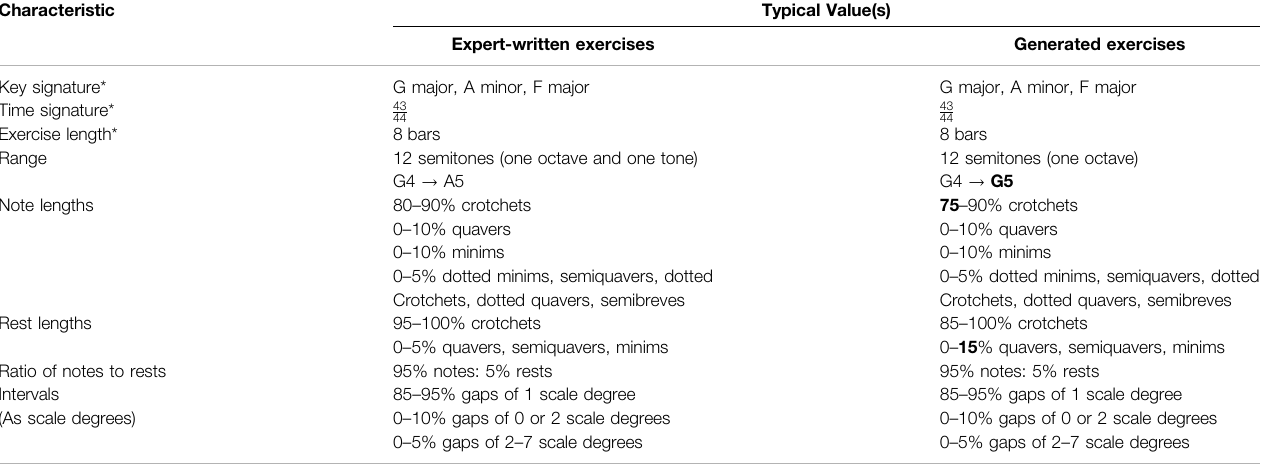
TABLE 7 | Typical characteristics of expert-written and generated Grade 2 sight reading exercises. Ratios and proportions are represented in terms of time. Differences between the expert-written and generated exercises are highlighted in bold. Characteristics marked with ‘ * ’ are fi xed and not expected to change.